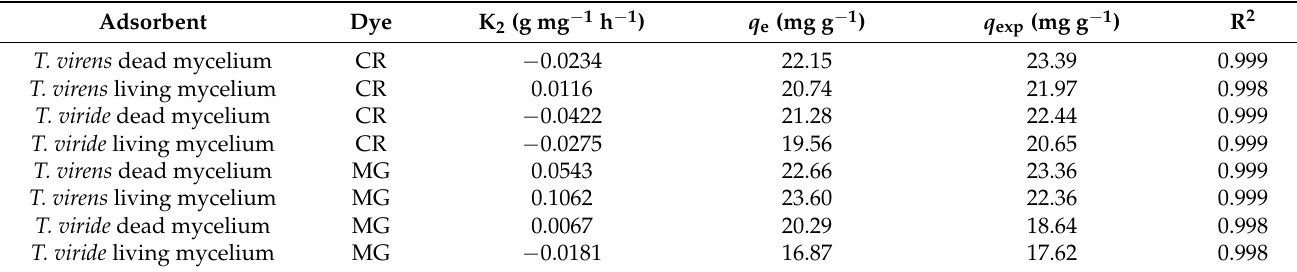
Table 2. Pseudo-second-order kinetic parameters for the removal of Congo red and malachite green by fungal fresh biomass of T. virens and T. viride .